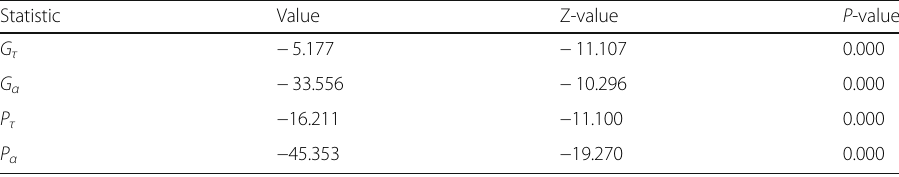
Table 2 Panel Asymptotic Cointegration Test